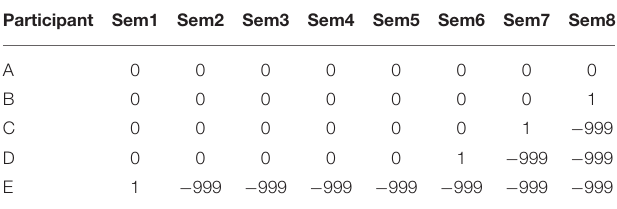
TABLE 2 | An example of person-level event history for selected